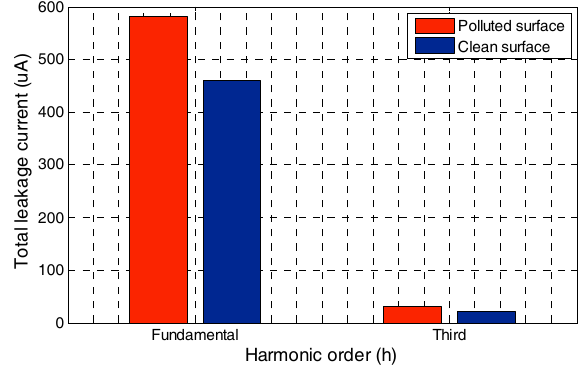
Figure 15. Harmonic components at 8 kV rms under clean and polluted surface.